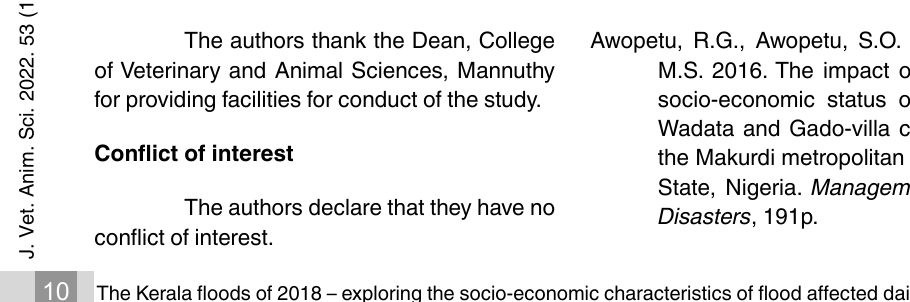
Table 1. Socio-economic characteristics of dairy farmers in Kerala flood 2018 Parameters f % Age 1-19 years 0 0 20-39 years